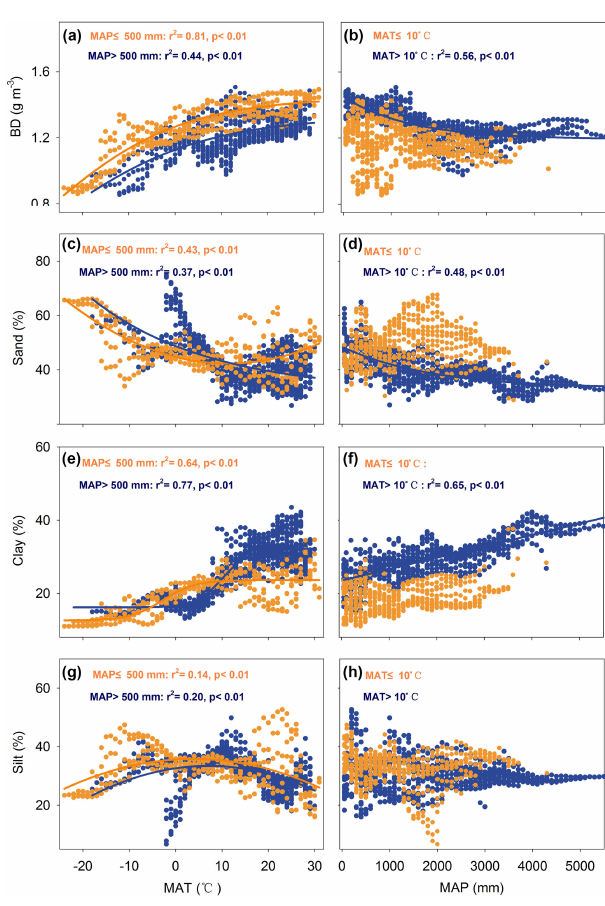
Figure 4. Changes in surface (0–30cm) soil bulk density (BD, gm − 3 ), sand fraction (%), clay fraction (%) and silt fraction (%) with mean annual precipitation (MAP) and mean annual tempera- ture (MAT). We used 500mm of MAP as a threshold of transition from arid to humid climate and 10 ◦ C of MAT as a threshold of tran- sition from cool to warm climate. (a, b) BD, (c, d) sand fraction, (e, f) clay fraction, and (g, h) silt fraction. Each dot shows the average value within each 1 ◦ C MAT and 100mm MAP.